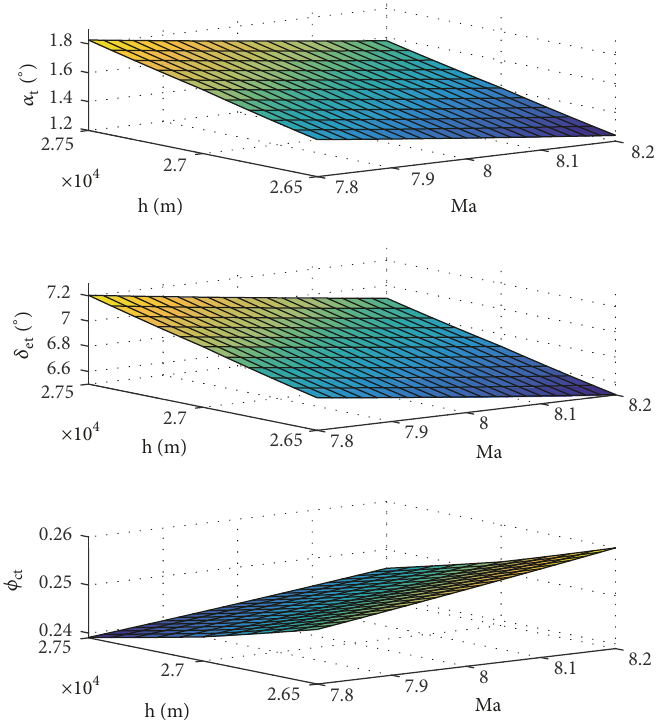
Figure 4: Change surfaces of trim values with regard to 𝑀𝑎 = 7.8 − 8.2 and ℎ = 26.5𝑘𝑚 − 27.5𝑘𝑚 .